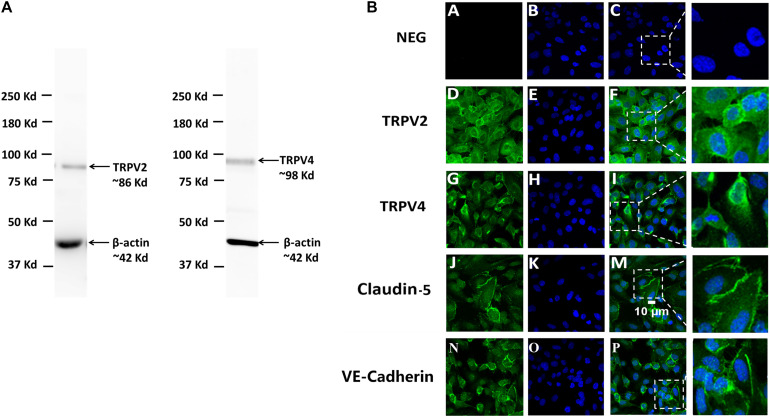
Protein expression of TRPV2 and TRPV4 in hCMEC/D3. (A) Expression of TRPV2 and TRPV4 determined by Western blot of total crude proteins obtained from two different protein extractions of hCMEC/D3. β-actin served as a loading control housekeeping protein. (B) Confocal immunofluorescence localization of TRPV2 and TRPV4 in hCMEC/D3. TRPV2 or TRPV4 (green) and nuclei (blue) were stained in hCMEC/D3 as described in section “Materials and Methods” (second D, E, F and third G, H, I row panels). Claudin-5 (green) and nuclei (blue) were stained in hCMEC/D3 (fourth row panel J, K, M). VE-Cadherin (green) and nuclei (blue) were stained in hCMEC/D3 (fifth row panel N, O, P). Control cells (NEG) were stained omitting the primary antibodies (first row panel A, B, C).